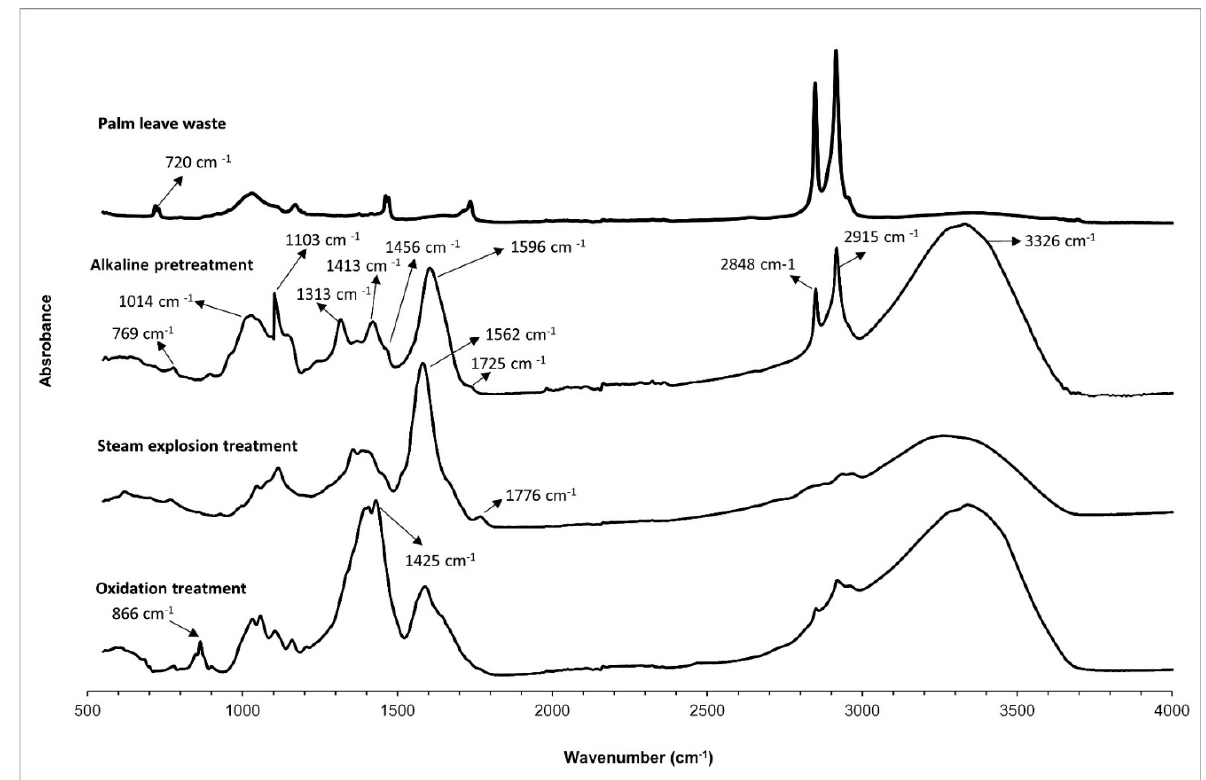
Figure 9. FTIR spectra of the dried waste generated at each step.